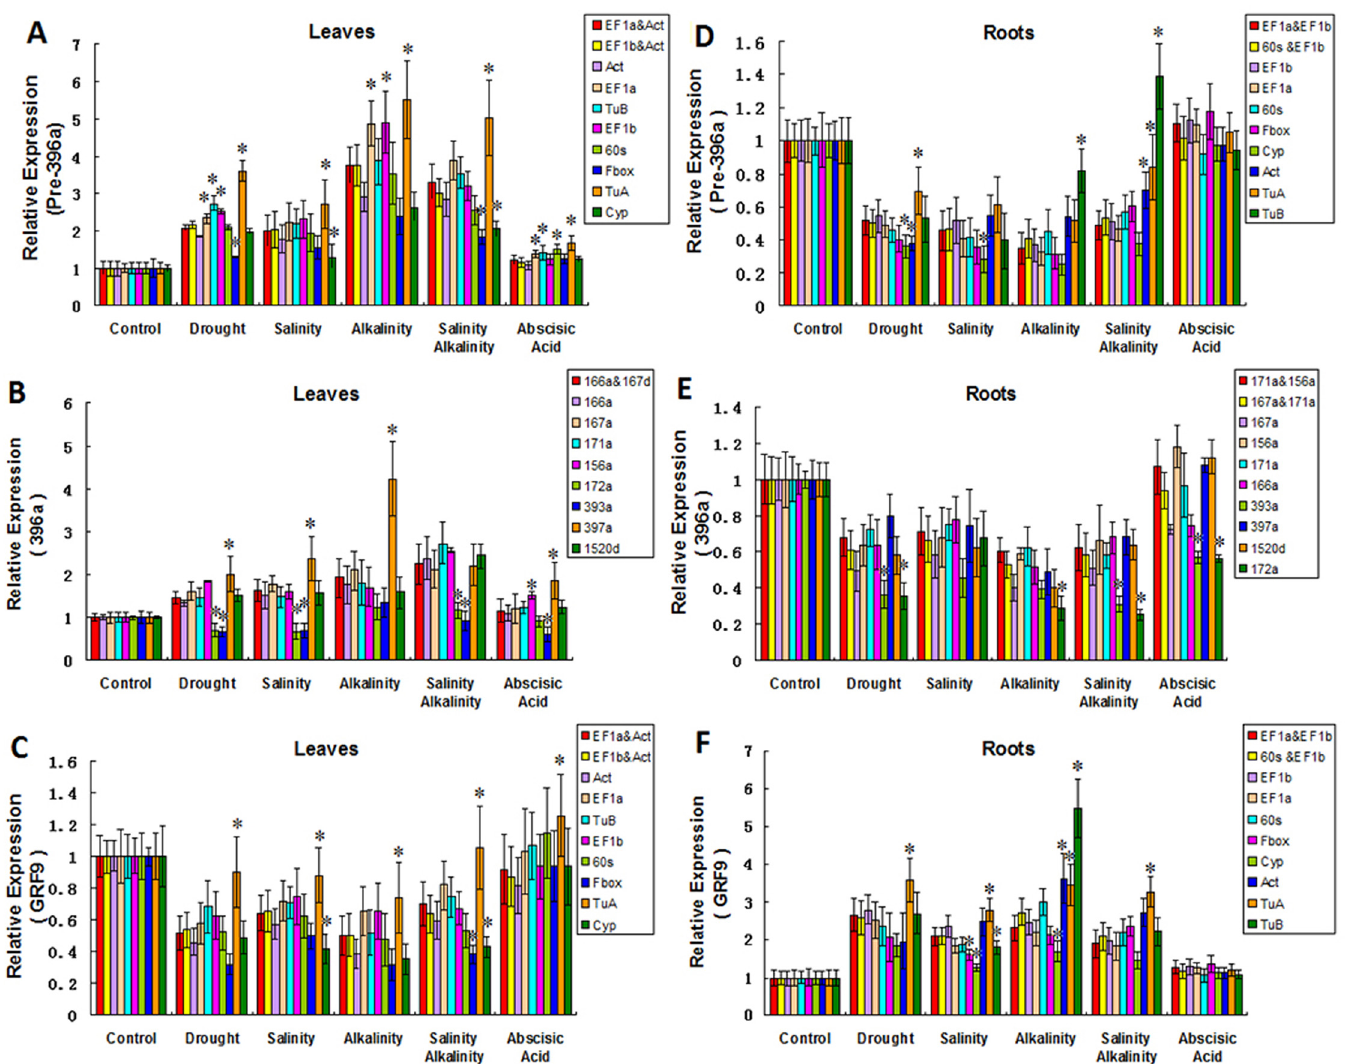
Fig 4. Validation of reference mRNAs and reference miRNAs for relative quantification under various stress conditions. Comparison of Pre-396a, 396a, and GRF9 relative expression levels determined using data normalized with the best reference mRNA/miRNA combination (according to geNorm and NormFinder) and each candidate reference mRNA/miRNA (consensus ranking from best to worst). (A) Pre-396a normalized by the best reference mRNA combination and each candidate reference mRNA in leaf samples; (B) Pre-396a normalized by the best reference mRNA combination and each candidate reference mRNA in root samples; (C) Mature miR396 normalized by the best reference miRNA combination and each candidate reference miRNA in leaf samples; (D) Mature miR396 normalized by the best reference miRNA combination and each candidate reference miRNA in root samples; (E) GRF9 normalized by the best reference mRNA combination and each candidate reference mRNA in leaf samples; (F) GRF9 normalized by the best reference mRNA combination and each candidate reference mRNA in root samples. Samples were treated for 3 h with various stresses (PEG-simulated drought, salinity, alkalinity, salinity+alkalinity, and ABA). The error bars represent the standard deviations (SD) of three biological replicates. P < 0.05 (instead of * ) indicated a significant difference according to one way analysis of variance between the data normalized using the recommend combinations or the best reference mRNA/miRNA and the data normalized using the other candidate